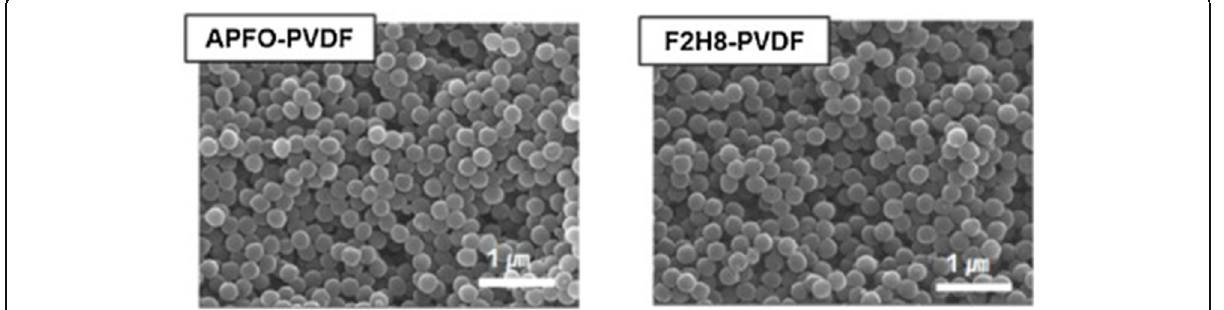
Fig. 6 SEM images of the PVDF particles obtained using APFO and F 2 H 8 as surfactants [47]. Copyright 2018,